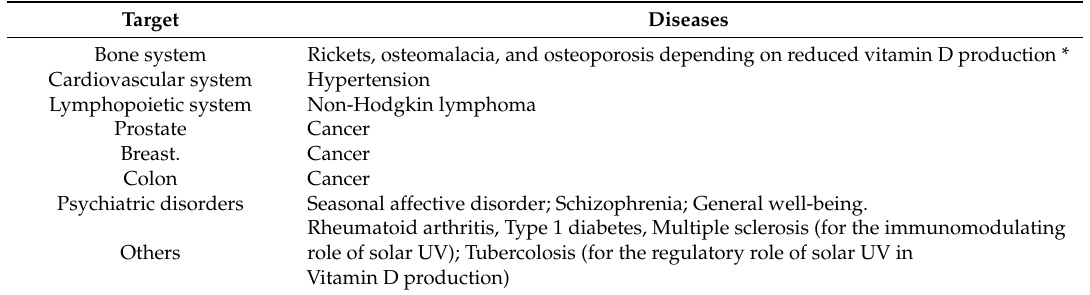
Table 2. Beneficial effects on diseases of solar radiation exposure (WHO 2006, adapted) [38].